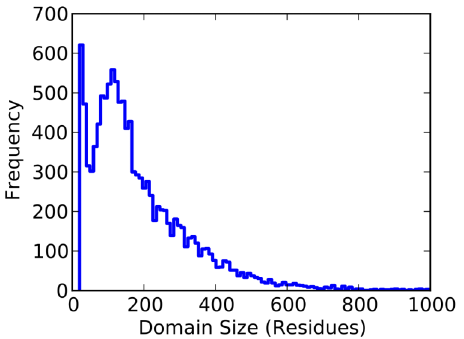
Figure 1. The size distribution of non-homologous protein domains listed in the PDB. Of the 12,151 sequences reported, 39 are larger than 1000 residues (0.32%) - while not shown here for clarity, they were included in subsequent analyses. Data were obtained from the NIH’s VAST algorithm (http://www.ncbi.nlm.nih.gov/Structure/ VAST/nrpdb.html) on 5/5/2012 with a dissimilarity p-value of 10 { 7 .